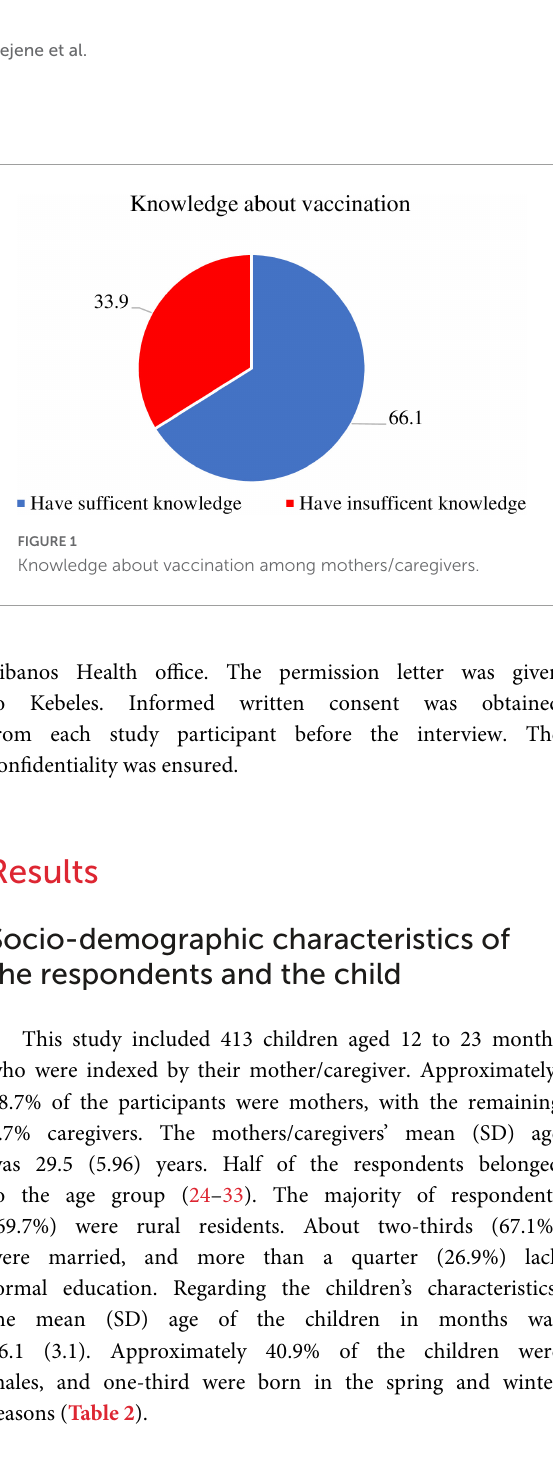
FIGURE1 Knowledge about vaccination among mothers/caregivers.